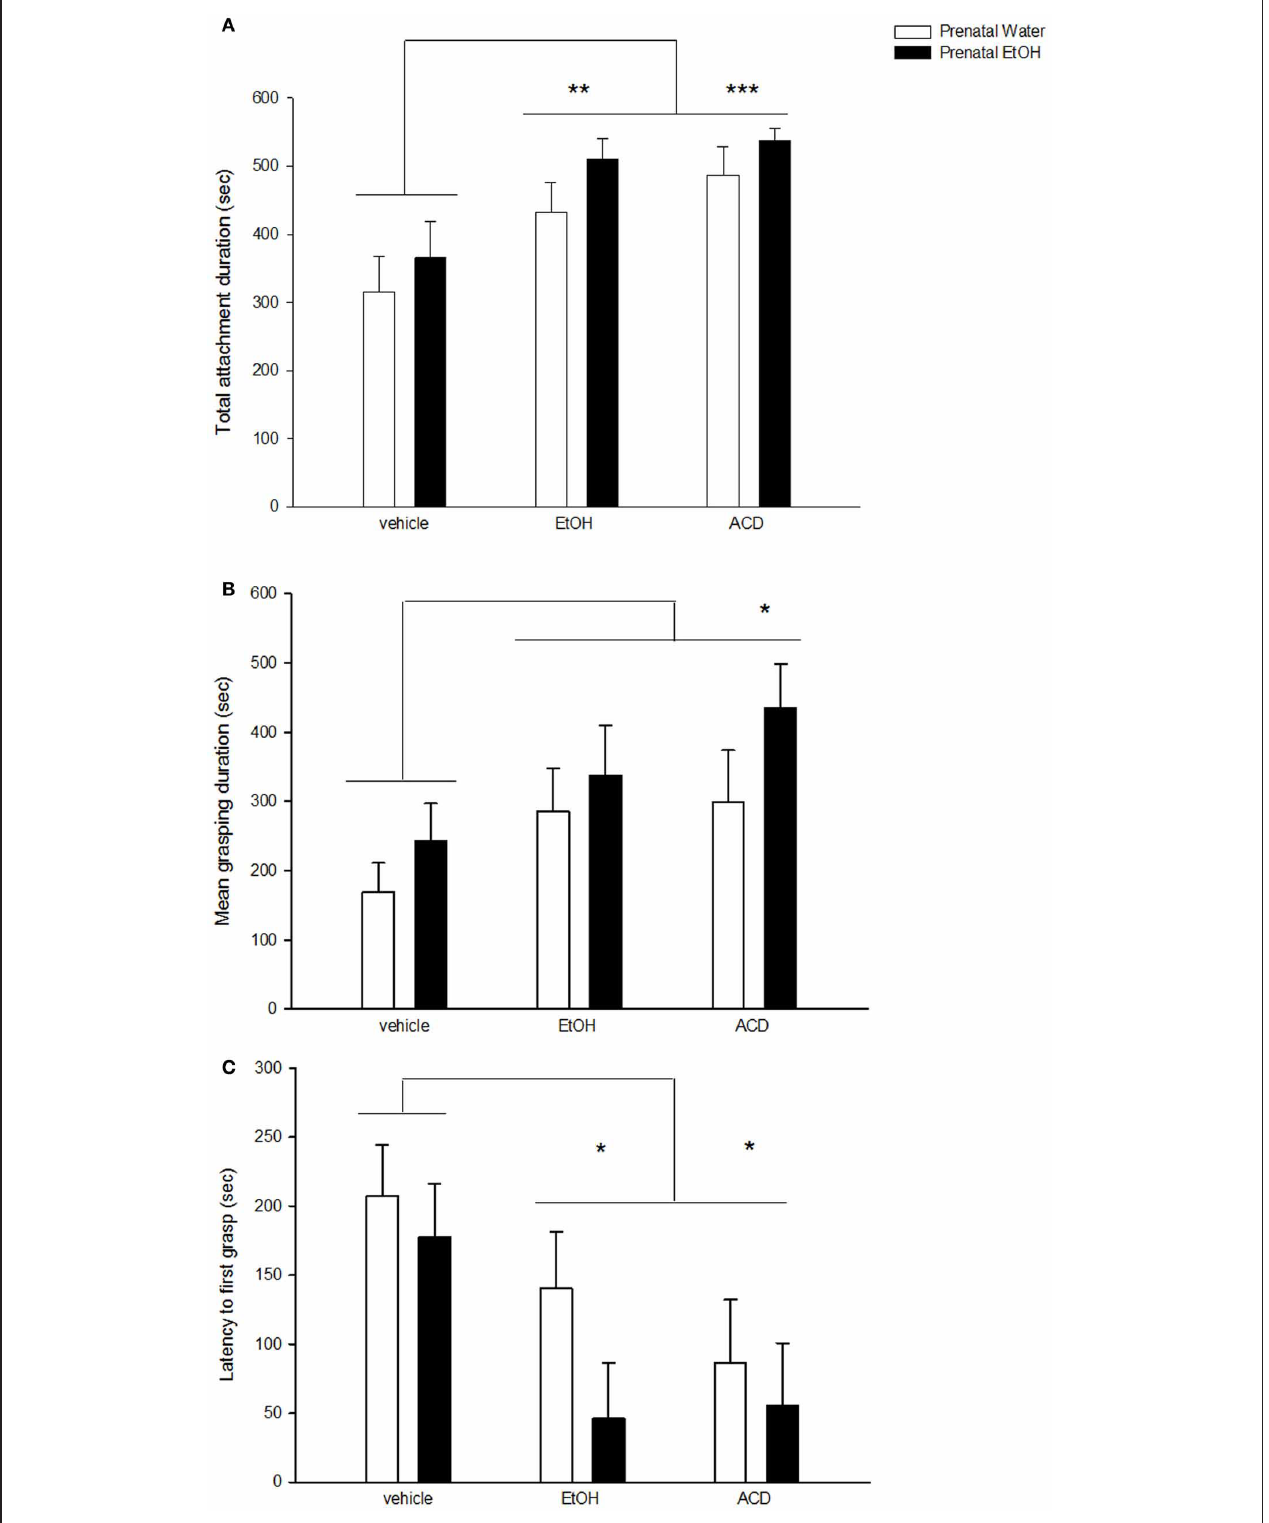
FIGURE 1 | Effect of prenatal exposure to EtOH on attachment behavior to a surrogate nipple in the presence of an odor conditioned to EtOH or ACD. Data represent mean + SEM in seconds of (A) total attachment